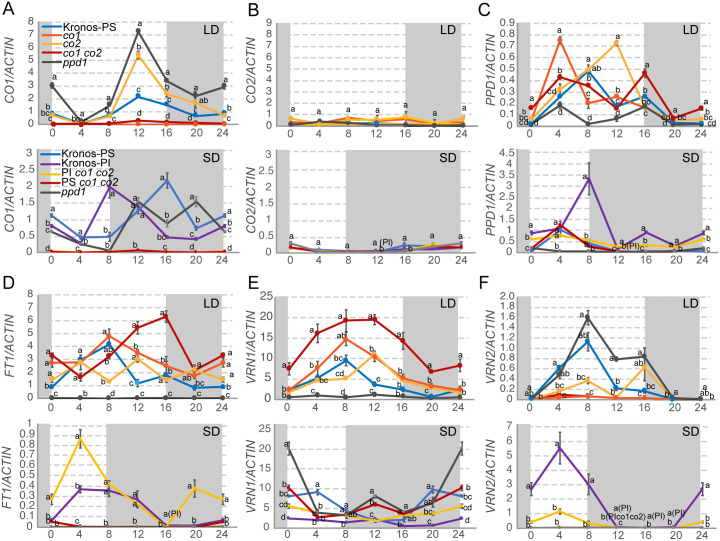
Effect of loss-of-function mutations in CO1, CO2 and PPD1 on the transcriptional profiles of six wheat flowering genes in Kronos-PS and Kronos-PI (SD-only) plants grown under LD and SD.(A) CO1, (B) CO2, (C) PPD1, (D) FT1, (E) VRN1, and (F) VRN2. LD experiments included Kronos-PS, co1, co2, co1 co2, and ppd1 mutants; whereas SD experiments included Kronos-PS, Kronos-PI, and their respective co1 co2 and ppd1 mutants. We grew the plants in a growth chamber under 16 h light at 22 °C and 8 h darkness at 17 °C for LD, and under 8 h light and 16 h darkness for SD (same temperatures). Fully expanded 4th leaves (Zadoks scale = 14) were harvested at ZT0, ZT4, ZT8, ZT12, ZR16, and ZT20. The ZT0 value is the same as at ZT24. Shaded boxes represent night. Values are averages of four biological replicates and bars are SE of the means. Expression values are relative to ACTIN using the delta Ct method. Primers and primer efficiencies are listed in S5 Table (all amplify both A and B homologs of the respective genes).